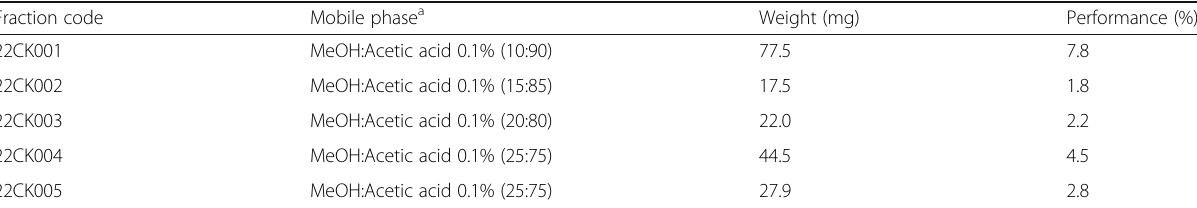
Table 3 Open column chromatographic fractionation of the active fraction Pg- YP-I-22C obtained from the ethanolic extract of P. guajava